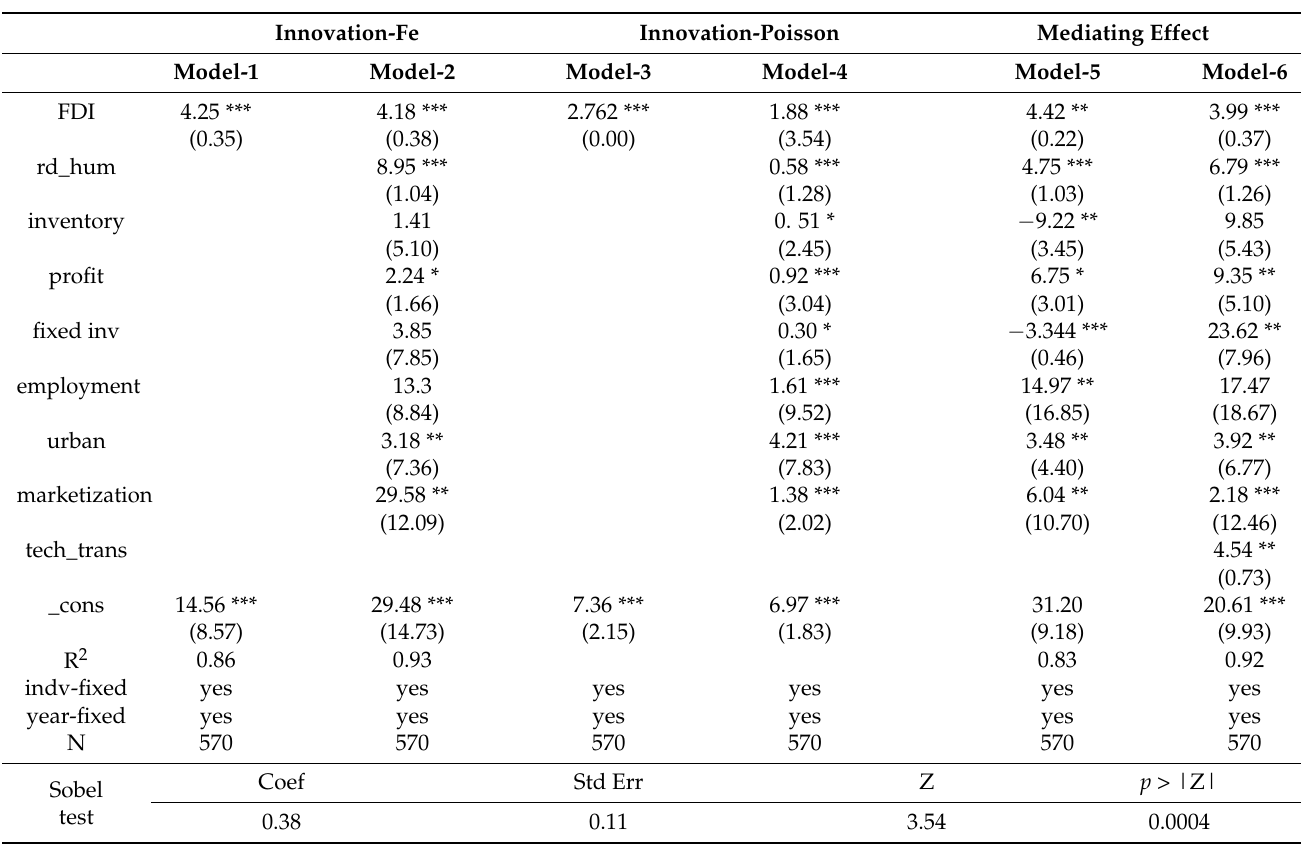
Table 3. Regression on the main effect and mediating